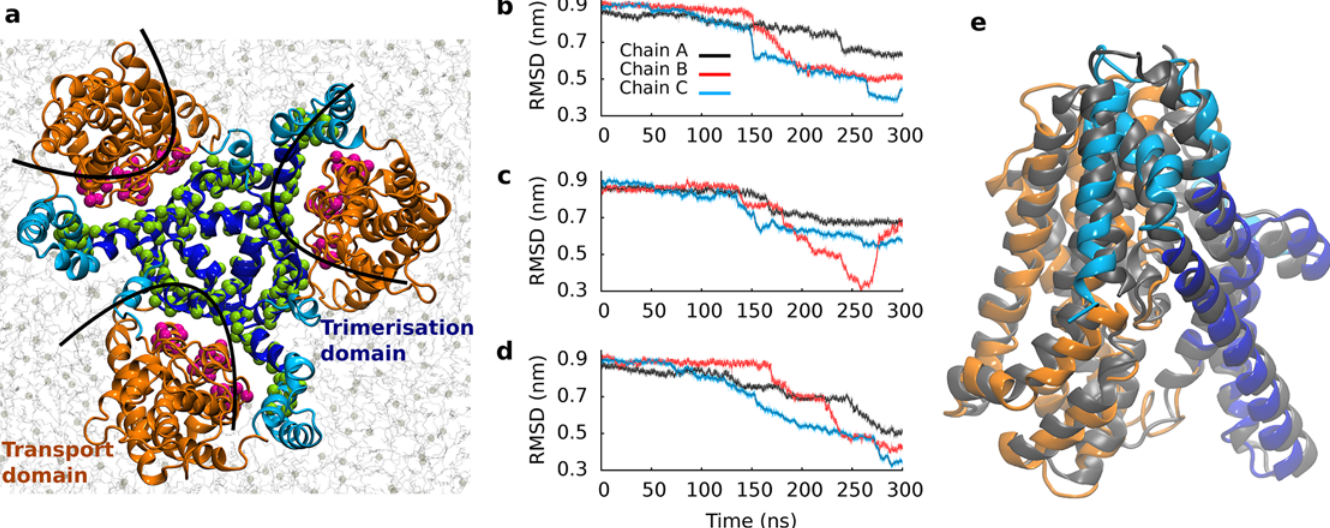
Fig 1. Global structure of GltPh. (a) Membrane embedded trimeric transporter structure, seen from the extracellular site. The transport domain is shown in orange, the trimerization domain in light (membrane exposed) and dark blue (without membrane contacts). The same color code is applied to all figures. The backbone atoms used as pulling groups are highlighted in green and purple. (b-d) Time evolution of transporter geometry is shown of three independent simulations, measuring the structural deviation of each protomer individually (chain A in black, chain B in red, chain C in blue) from the inward-facing crystal structure. (e) Overlay of the inward-facing crystal structure in gray (PDB ID: 3KBC) and the closest conformation extracted from the SMD simulation. The RMSD between the structures was 0.35 nm.